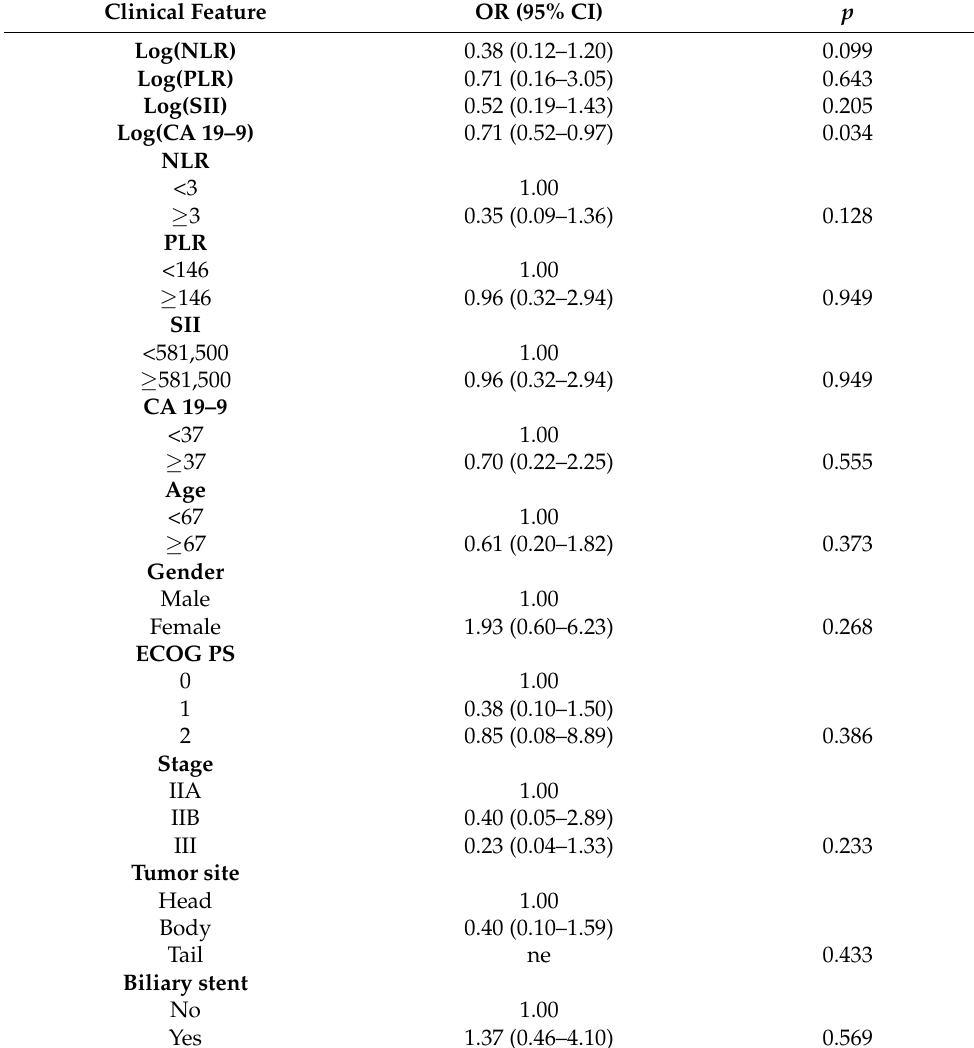
Table 7. Association between patient characteristics and